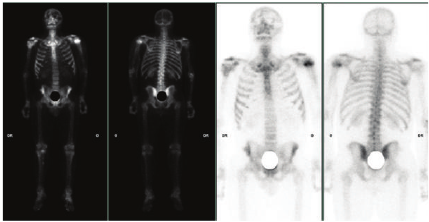
Figure 4: 99 m Tc bone scan revealing uptake only at the site of the fracture of the left humeral